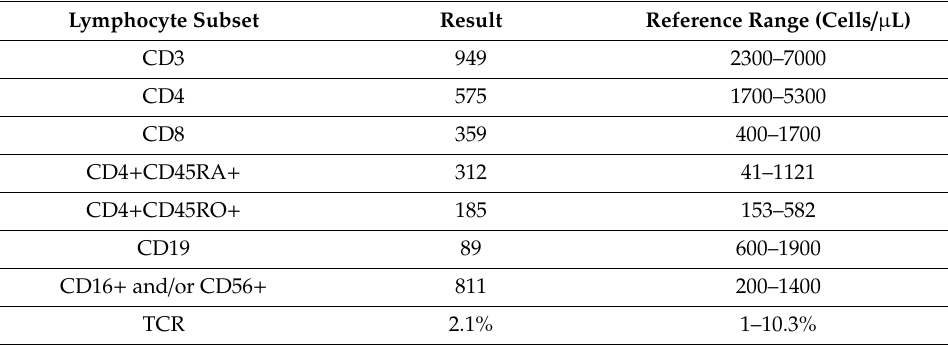
Table 6. Case 4, lymphocyte subset analysis including naïve and memory T